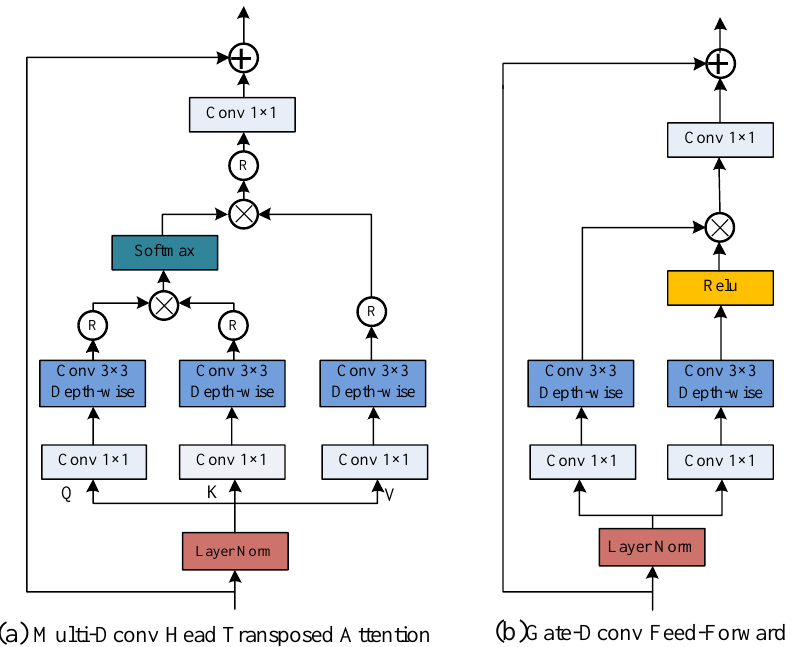
Figure 3. The structure of the transformer block.